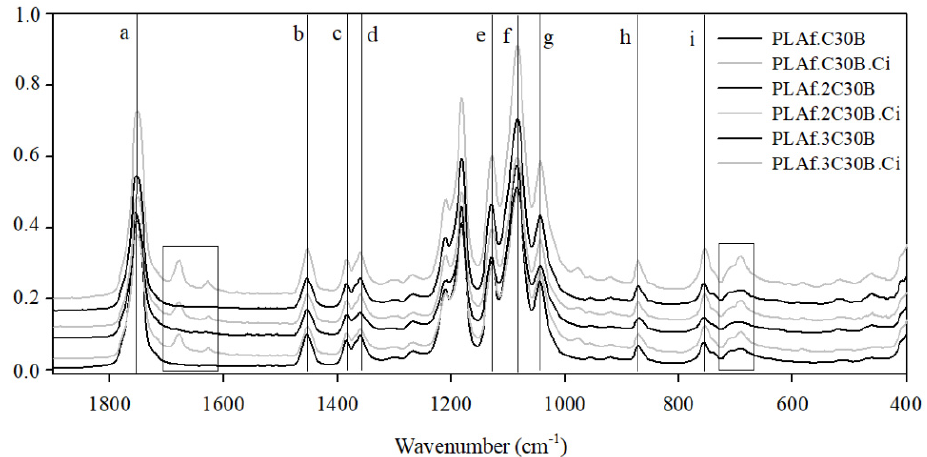
Figure 3. FTIR spectra of foams, including nanoclays, control foams (dark lines), and foams contain- ing cinnamaldehyde (bright lines). From bottom to top: PLAf.1C30B, PLAf.1C30.Ci, PLAf.2C30B, PLAf.2C30.Ci, PLAf.3C30B, and PLAf.3C30.Ci.